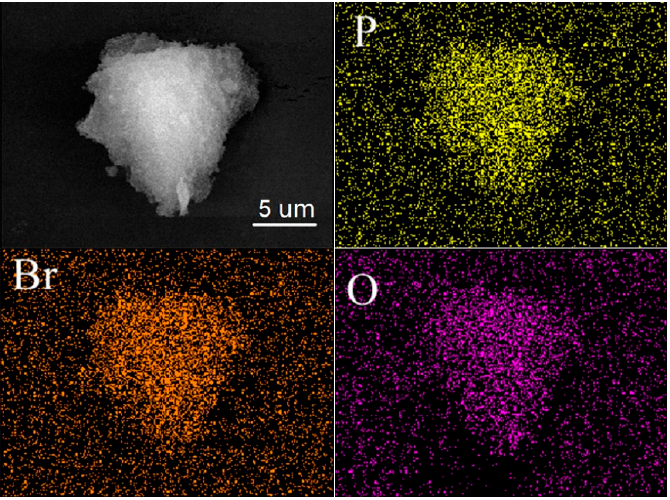
Figure 5. SEM ‐ mapping of PQPBr ‐ 2OH. Figure 5. SEM-mapping of